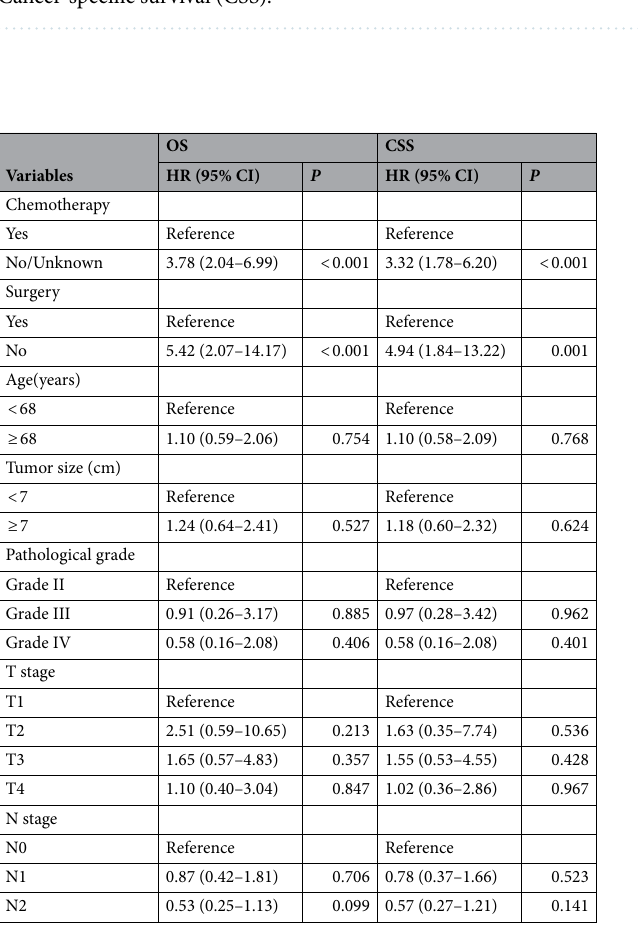
Figure 4. Directed Acyclic Graphs (DAG) exhibit the impact of chemotherapy on Overall Survival (OS) and Cancer-specific survival (CSS).